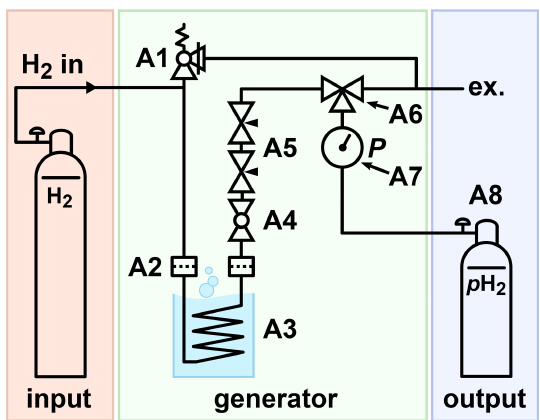
Figure 3. Schematic view of the PHG. H 2 gas was supplied via the inlet, e.g. from a 50L 200-bar cylinder. The gas flowed through a filter (A2) into the ortho-para-conversion unit (A3) immersed in lN 2 , where it cooled down and thus was enriched with the p H 2 component. The parahydrogen-enriched gas exited the ortho-para- conversion unit, warmed up, and passed another particle filter. The filters reduced the contamination of the setup with the catalyst. A ball valve (A4) was used to start or stop the gas flow. Two needle valves (A5) were used to control the flow rate. A three-way valve (A6) allowed the storage cylinder to be filled or drained. A 100-bar safety valve (A1) was connected to the system to relieve a potential excess of